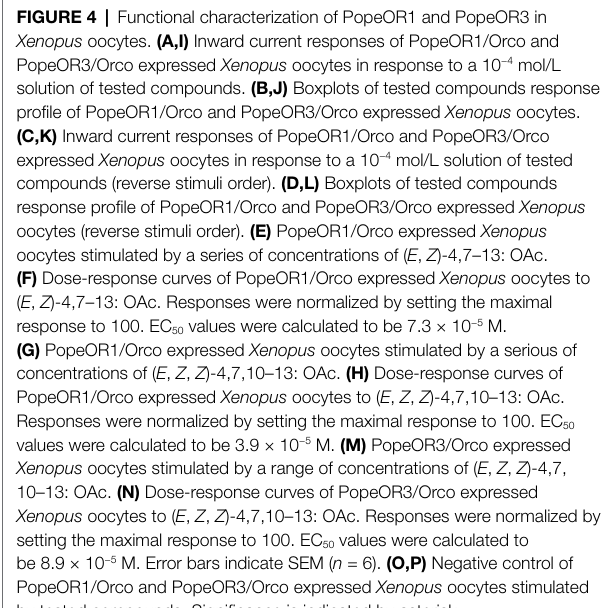
FIGURE 4 | Functional characterization of PopeOR1 and PopeOR3 in Xenopus oocytes. (A,I) Inward current responses of PopeOR1/Orco and PopeOR3/Orco expressed Xenopus oocytes in response to a 10 −4 mol/L solution of tested compounds. (B,J) Boxplots of tested compounds response profile of PopeOR1/Orco and PopeOR3/Orco expressed Xenopus oocytes. (C,K) Inward current responses of PopeOR1/Orco and PopeOR3/Orco expressed Xenopus oocytes in response to a 10 −4 mol/L solution of tested compounds (reverse stimuli order). (D,L) Boxplots of tested compounds response profile of PopeOR1/Orco and PopeOR3/Orco expressed Xenopus oocytes (reverse stimuli order). (E) PopeOR1/Orco expressed Xenopus oocytes stimulated by a series of concentrations of ( E , Z )-4,7–13: OAc. (F) Dose-response curves of PopeOR1/Orco expressed Xenopus oocytes to ( E , Z )-4,7–13: OAc. Responses were normalized by setting the maximal response to 100. EC 50 values were calculated to be 7.3 × 10 −5 M. (G) PopeOR1/Orco expressed Xenopus oocytes stimulated by a serious of concentrations of ( E , Z , Z )-4,7,10–13: OAc. (H) Dose-response curves of PopeOR1/Orco expressed Xenopus oocytes to ( E , Z , Z )-4,7,10–13: OAc. Responses were normalized by setting the maximal response to 100. EC 50 values were calculated to be 3.9 × 10 −5 M. (M) PopeOR3/Orco expressed Xenopus oocytes stimulated by a range of concentrations of ( E , Z , Z )-4,7, 10–13: OAc. (N) Dose-response curves of PopeOR3/Orco expressed Xenopus oocytes to ( E , Z , Z )-4,7,10–13: OAc. Responses were normalized by setting the maximal response to 100. EC 50 values were calculated to be 8.9 × 10 −5 M. Error bars indicate SEM ( n = 6). (O,P) Negative control of PopeOR1/Orco and PopeOR3/Orco expressed Xenopus oocytes stimulated by tested compounds. Significance is indicated by